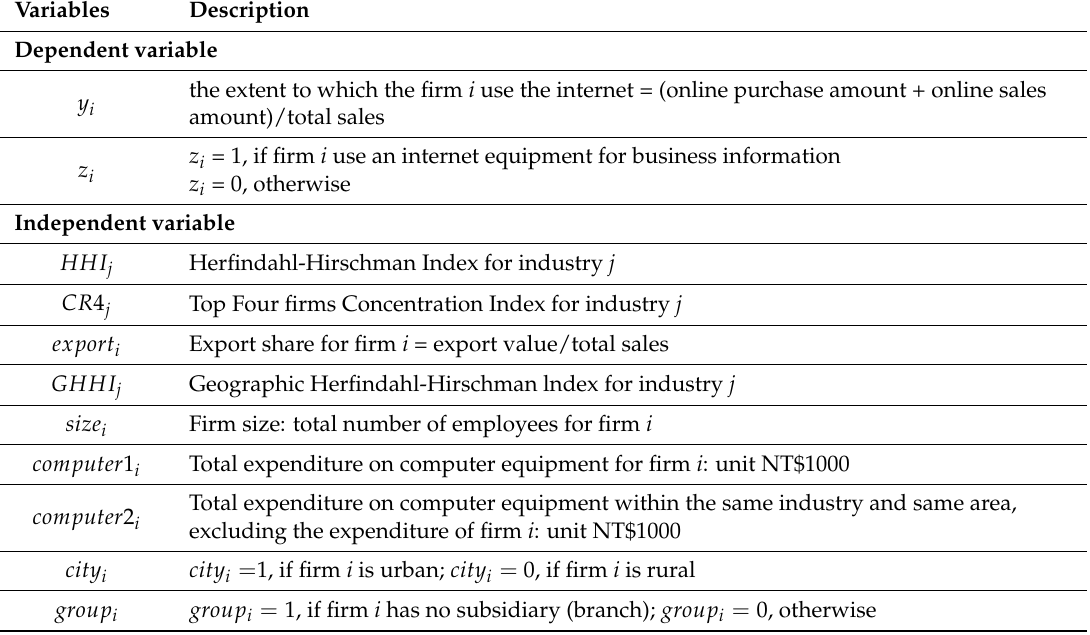
Table 2. Variable Definitions.